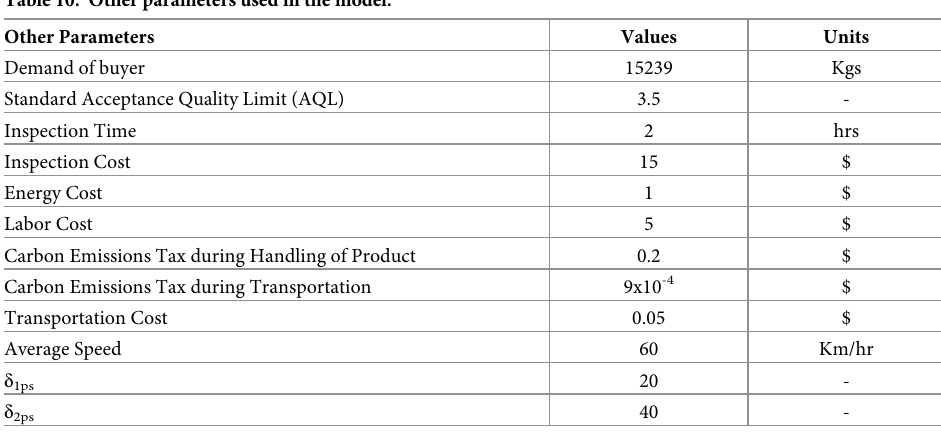
Table 10. Other parameters used in the model.